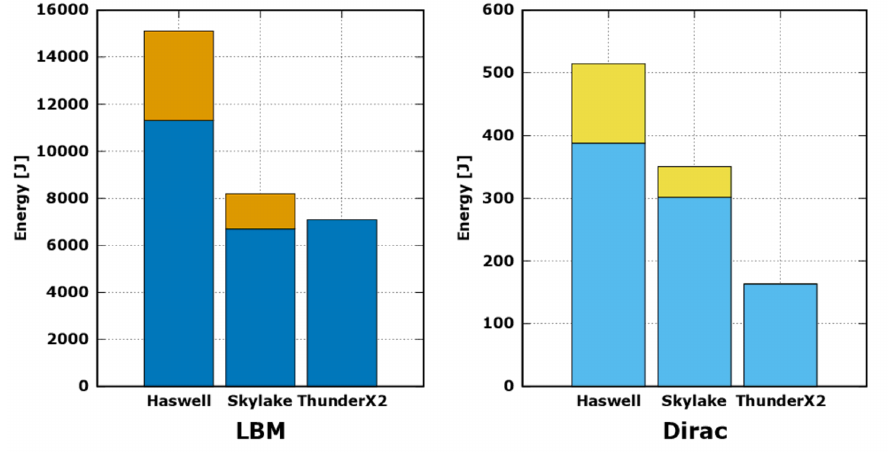
Figure 5. Average energy consumption provided by Intel RAPL counters for Haswell and Skylake processors, and by embedded sensors for ThunderX2 . RAPL counters provide also an additional reading of the DRAM energy consumption, reported here for reference as additional yellowish bars. Energy consumption is reported as average over 100